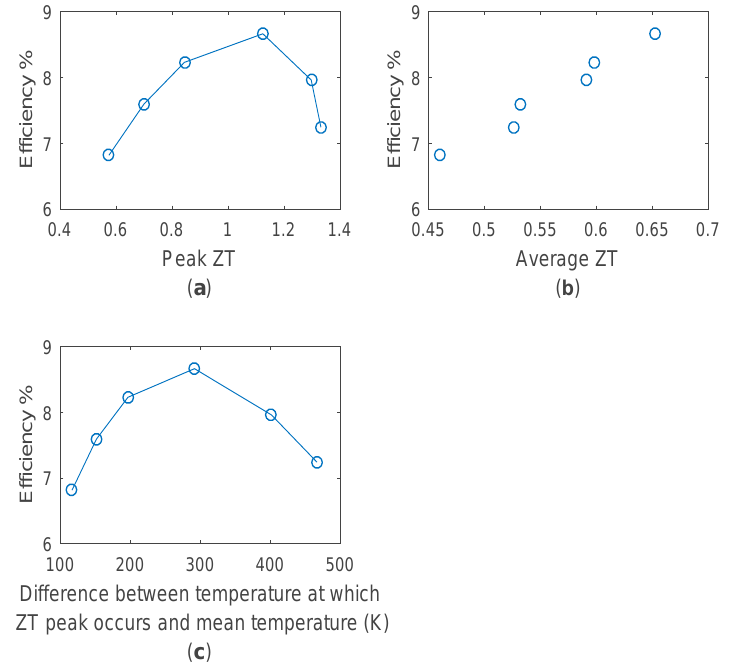
Figure 5. Calculated efficiency by FEA for n-type silicide material, for different material doping levels as a function of ( a ) peak ZT value; ( b ) average ZT value and ( c ) peak ZT position in temperature relative to the mean module temperature. Hot and cold side temperatures are 400 °C and 30 °C respectively.